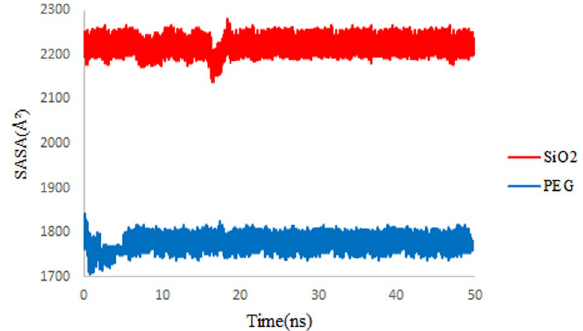
Figure 4. SASA values of 3TC on SiO 2 (red) and 3TC on PEG (blue) complexes during 50 ns